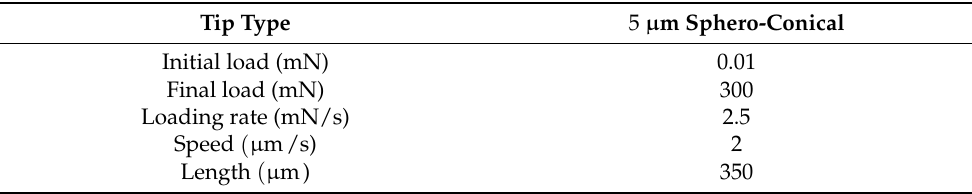
Table 3. Experimental condition of nano-scratch test. Tip